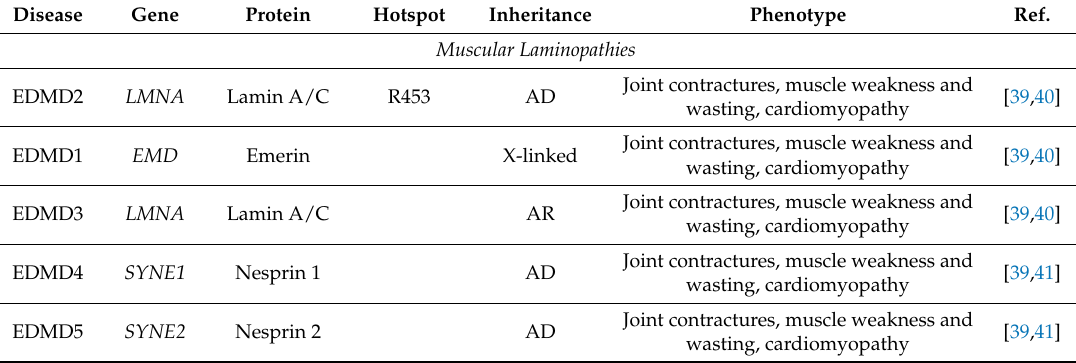
Table 1. The most representative laminopathies are listed. * nomenclature for these forms is provisional; ** potential hotspot; *** cardiomyopathy with conduction defect type 1A